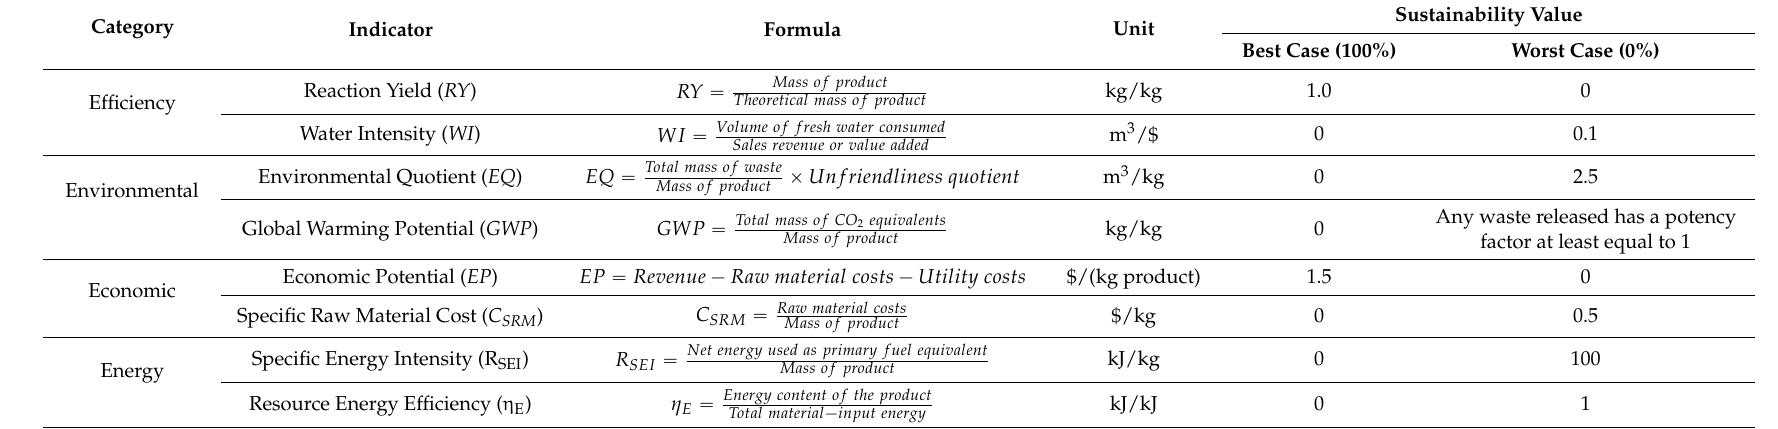
Table 1. Selected GREENSCOPE indicators and their reference